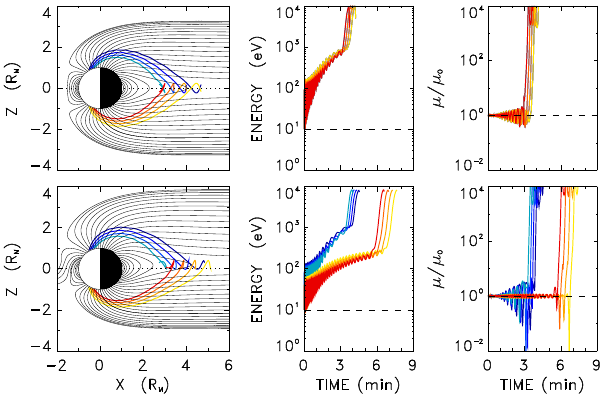
Fig. 4. Model Na + trajectories for (top) IMF B X = 0 and (bottom) IMF B X = 20nT. (from left to right) Trajectory projections in the X-Z planes, energy, and magnetic moment (normalized to the ini- tial value) as a function of time. The ions are launched with 10eV energy and 30 ◦ pitch angle on the noon meridian and from different latitudes (from 60 ◦ to 75 ◦ by steps of 5 ◦ ) in the Northern Hemi- sphere (blue color code) and in the southern one (yellow-red color code).